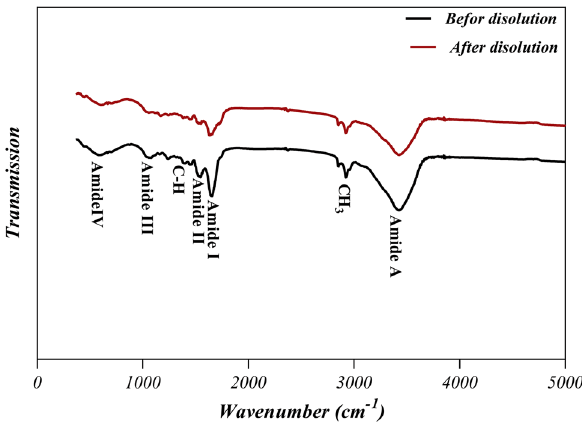
Figure 2. FTIR spectra of the amniotic membrane powder and the film resulting from its dissolution in the solvent FA/AA (70/30).